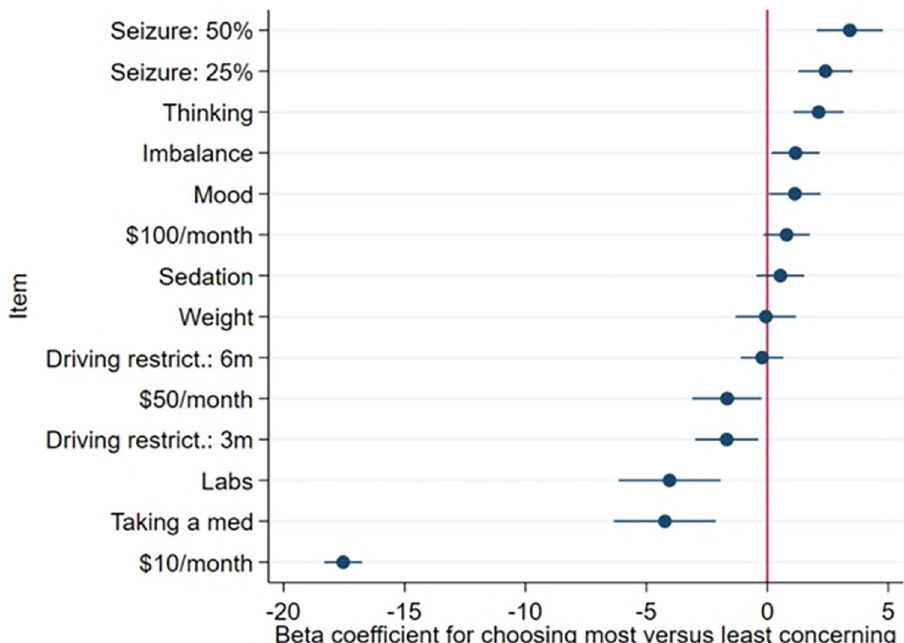
Fig 3. Coefficients and 95% confidence intervals for the patient multinomial logit of choosing each item as “most concerning” versus “least concerning”. The higher a coefficient, the greater the log(odds) was for choosing a given item as “most concerning” instead of “least concerning.” Thus, a 50% seizure risk was the most likely to be chosen as the most concerning item, whereas taking a medication was the least likely to be chosen as the most concerning. Coefficients are all in reference to a 10% seizure risk which is represented by the vertical red